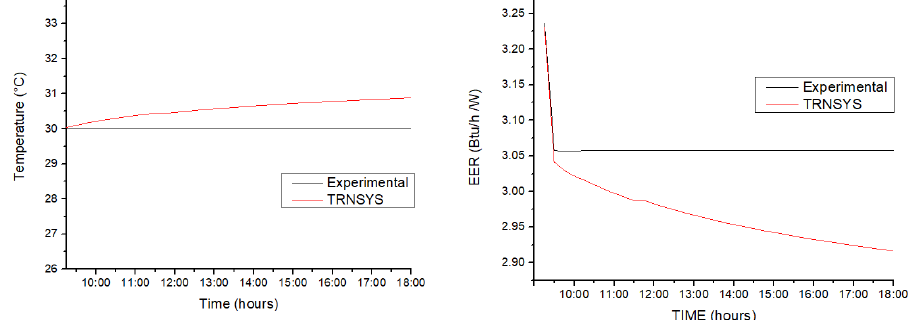
Figure 11. Comparison between simulated and experimental results of temperature and EER at a flow rate of 2GPM.